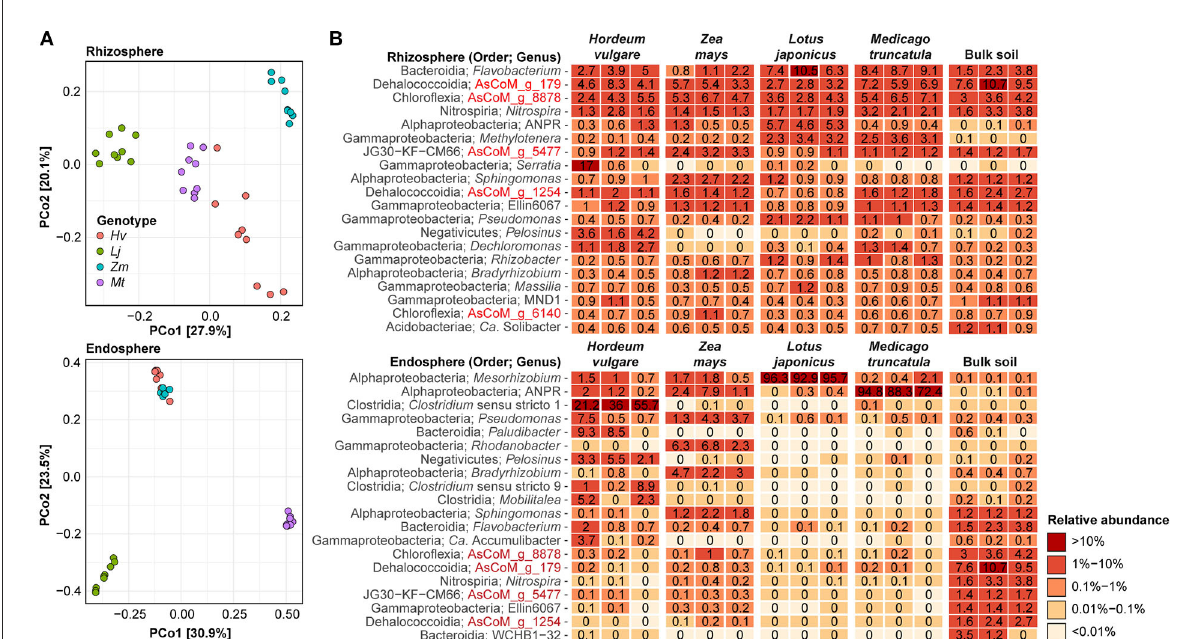
FIGURE6 Effect of plant species on the rhizosphere and endosphere microbiota. (A) Beta-diversity analysis using Bray–Curtis dissimilarities separates samples on the basis of host species for both the rhizosphere and endosphere compartments. (B) Percent relative abundance of the 20 most abundant genera within the rhizosphere and endosphere compartments. Three biological replicates are shown for each host species. The relative abundance for bulk soil is included for